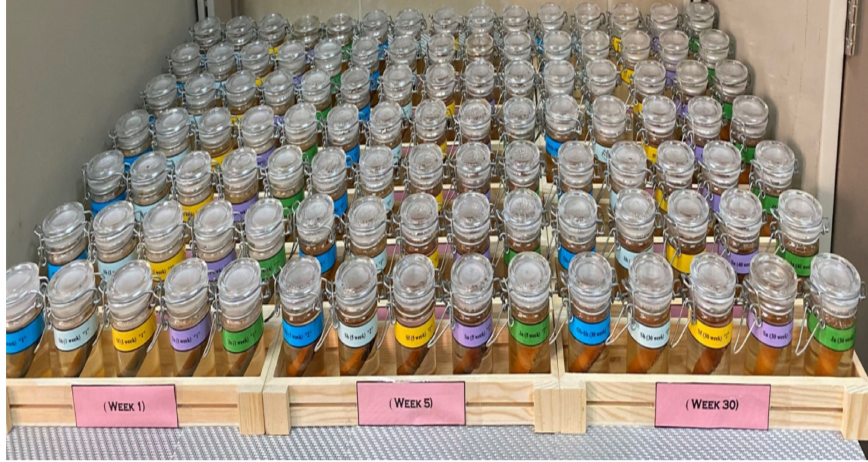
Figure 2. Final arrangement for weight loss experiments in Jeddah soil